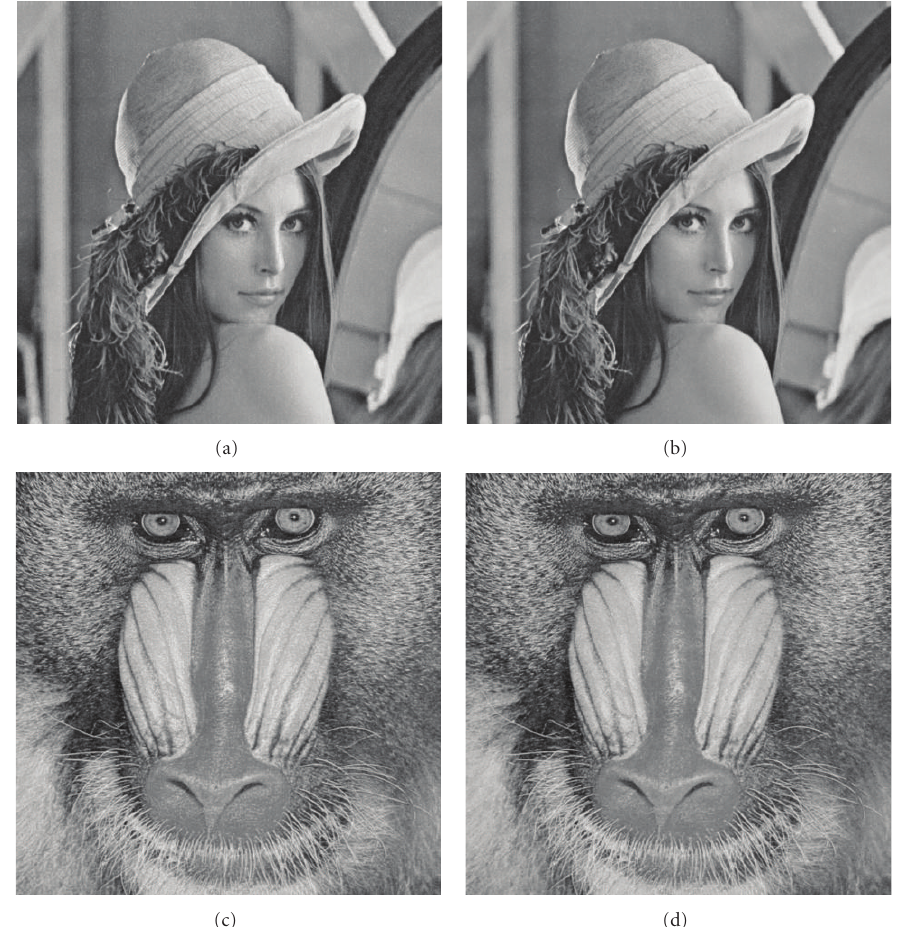
Figure 5: Two stego-images generated by the proposed method. (a) Stego-image 1 of Lena (33.19 dB), (b) stego-image 2 of Lena (34.25 dB), (c) stego-image 1 of Baboon (30.41 dB), and (d) stego-image 2 of Baboon (30.78